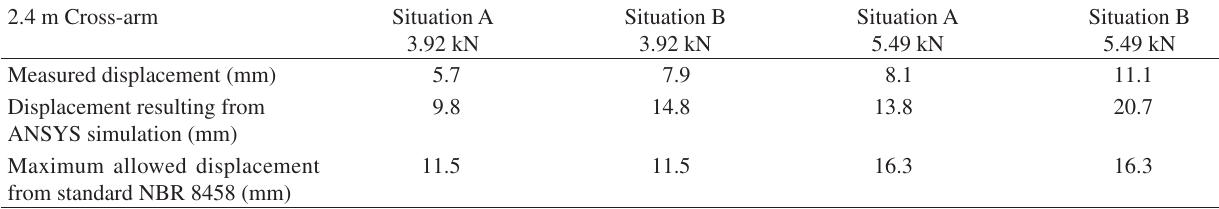
Table 2. Bending test results and simulations for Eucalyptus citriodora cross-arms.